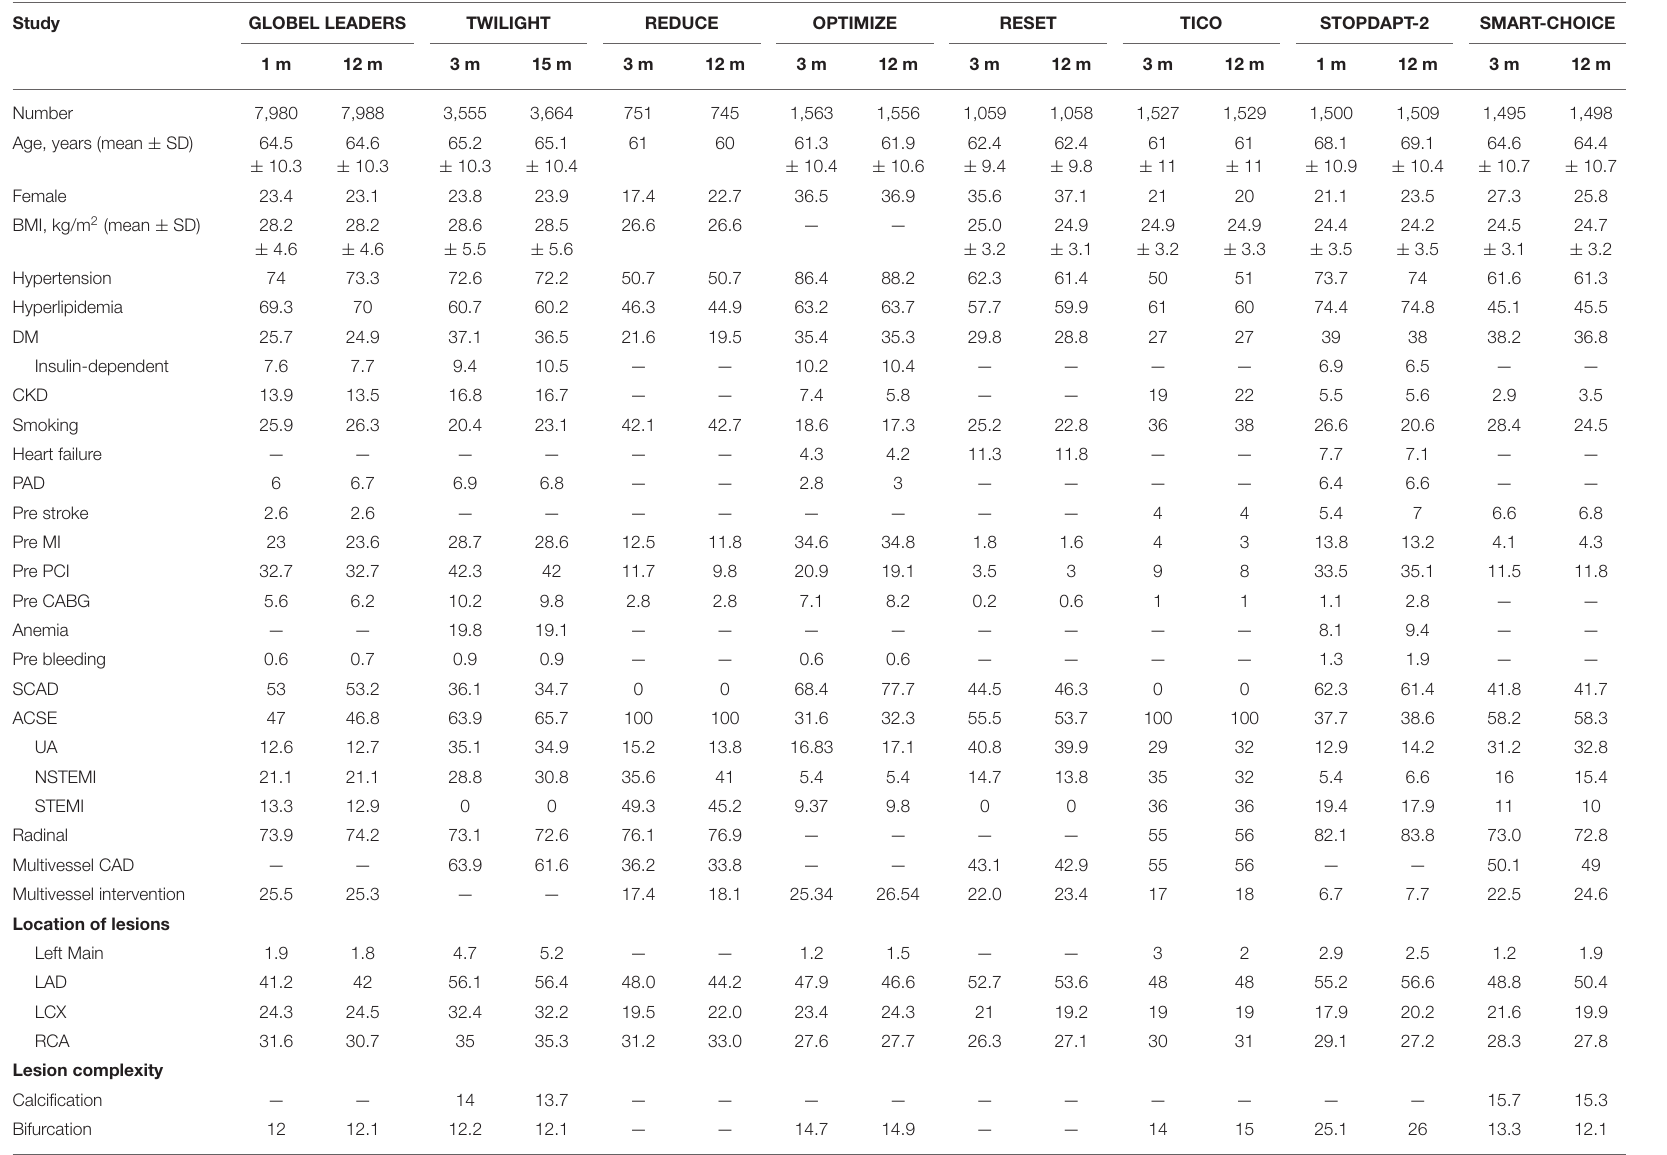
TABLE 2 | Clinical, angiographic, and procedure characteristics of the included